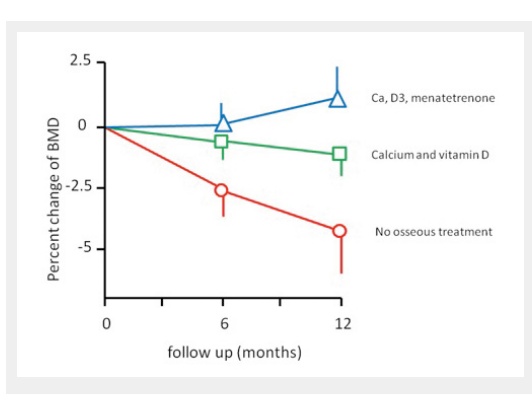
Metacarpal bone mineral density changes (mean + SEM) in patients with Parkinson’s disease, treated with menatetrenone, calcium and vitamin D, compared with calcium and vitamin D alone or without bone treatment (n = 56, 60 or 54 respectively). ANCOVA: p <0.001 for both groups treated with calcium and vitamin D vs untreated, and p = 0.05 for menatetrenone, calcium and vitamin D vs calcium and vitamin D alone [60, with permission of the editor].